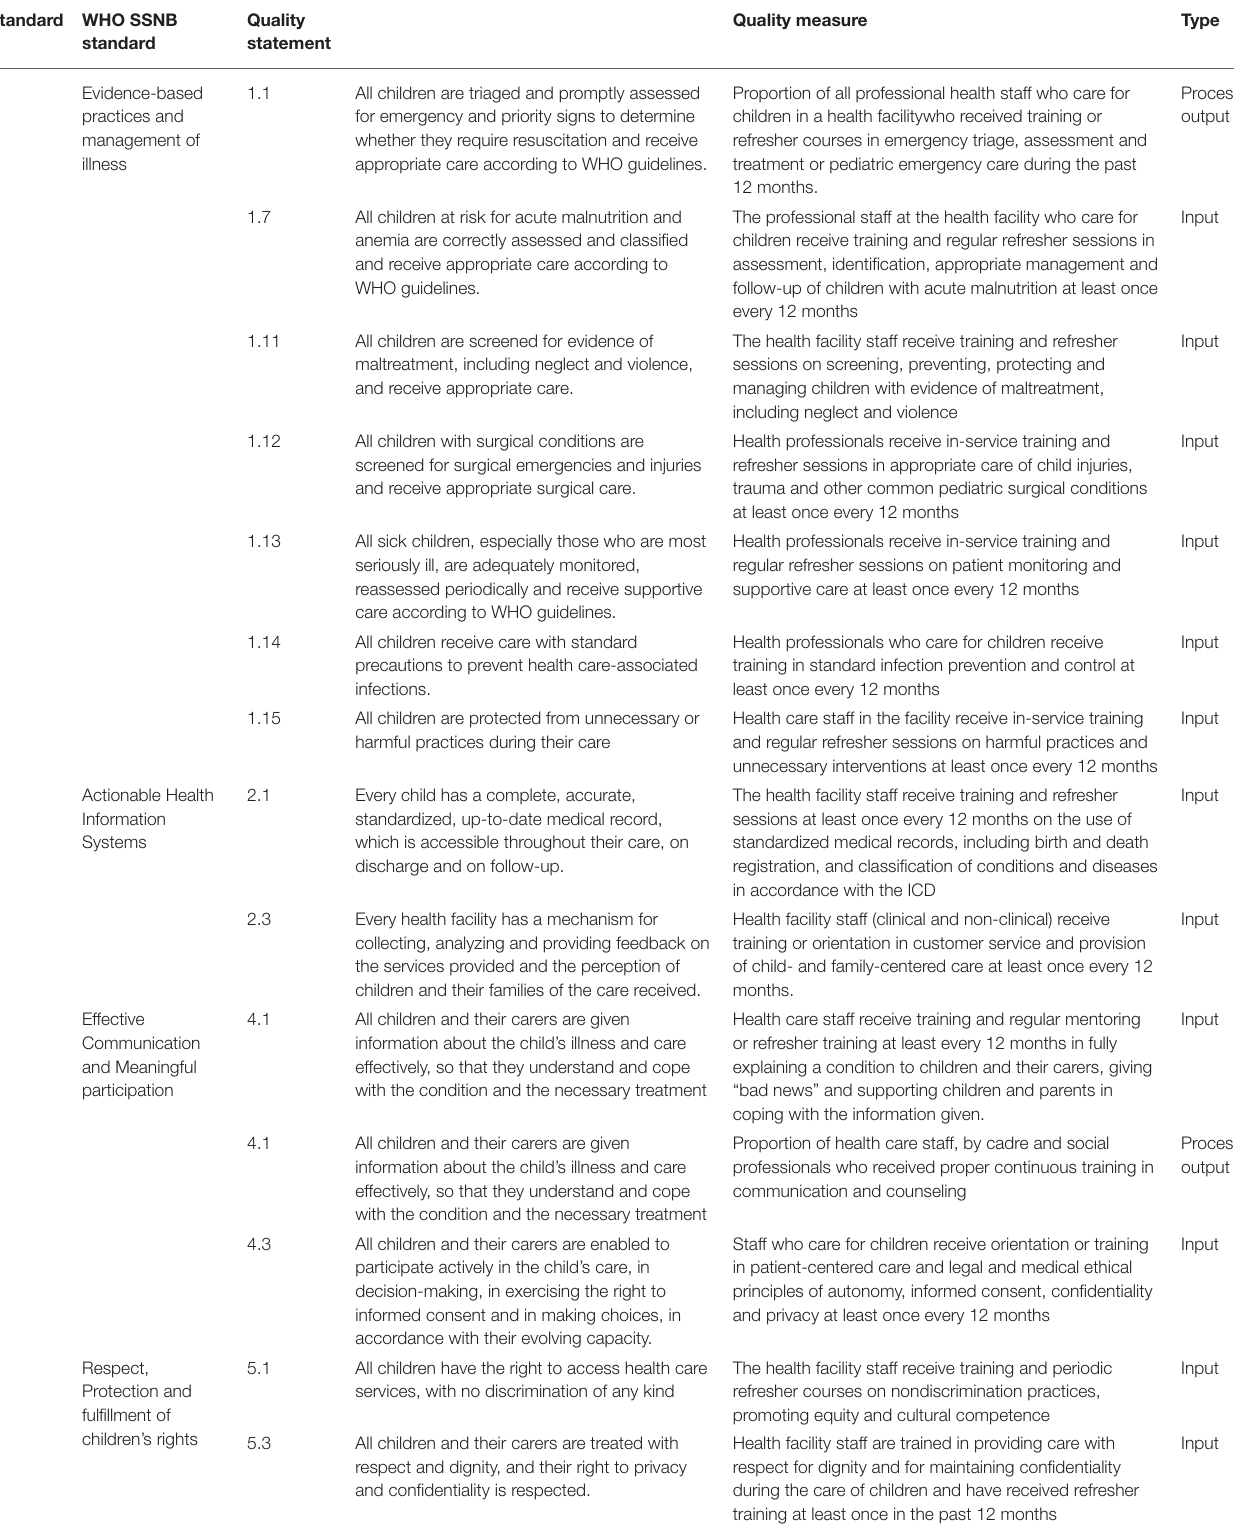
TABLE 1 | Pediatric critical care relevant training measures in the “Standards for improving the quality of care for children and young adolescents in health facilities” document